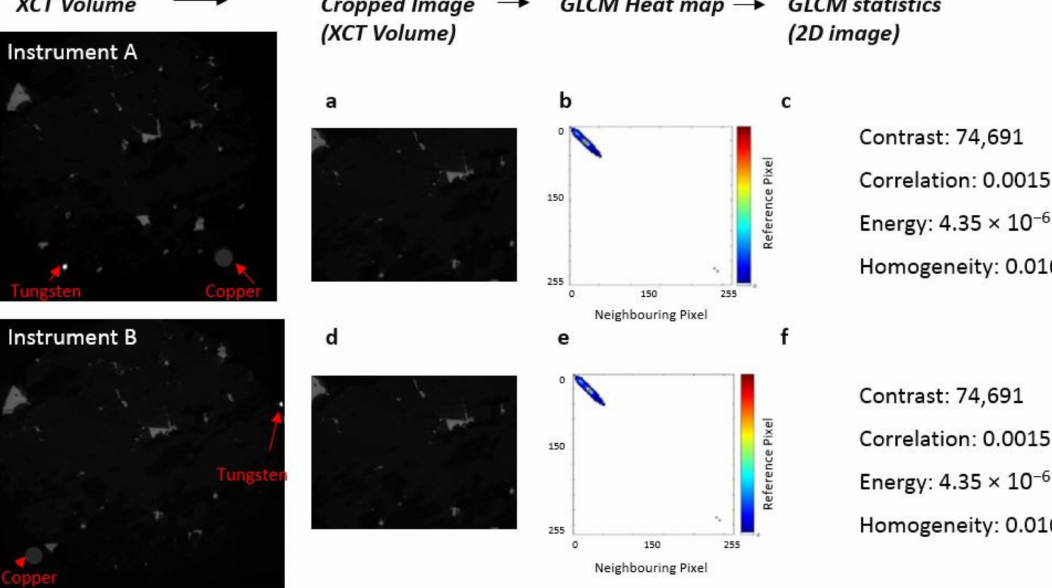
Figure 8. Comparison of the XCT data acquired by two XCT instruments using the three-point calibration ( a , b ), given for the magnetite-bearing quartzite. The images from the XCT volume ( a , d ) are cropped ( b , e ), and the accompanied GLCM outputs are given in the form of heat maps ( c , f ).